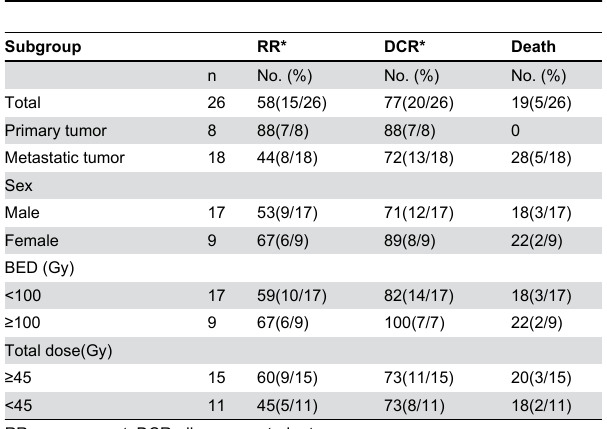
Table 2. Patient demographics and clinical characteristics. Characteristics